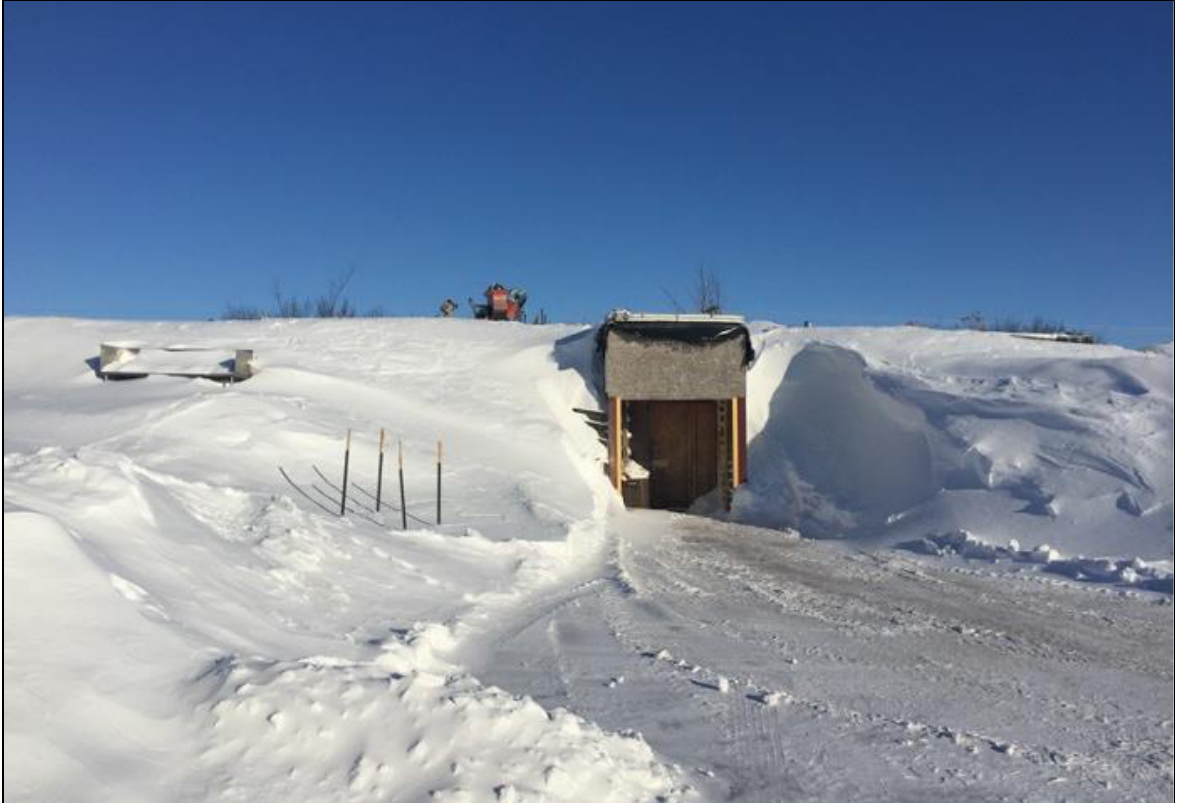
Figure 2. Produce Storage Bunker at Meyers